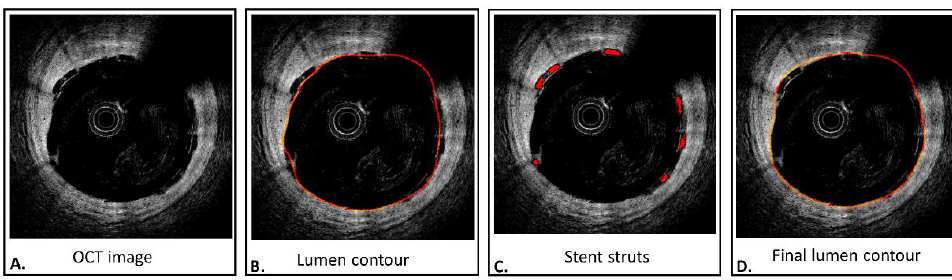
Figure 1. Main steps of the segmentation algorithm for the detection of lumen contours and polymeric stent struts. ( A ): Optical coherence tomography (OCT) frame of a coronary artery treated with the Absorb BVS (Abbott Vascular). ( B ): Detected lumen contour (a dilatation of 1 pixel has been applied to enable the edge visualization). ( C ): Regions of interests for the detected scaffold struts. ( D ): Final lumen contour after the correction with the scaffold struts (a dilatation of 1 pixel has been applied to enable edge visualization).